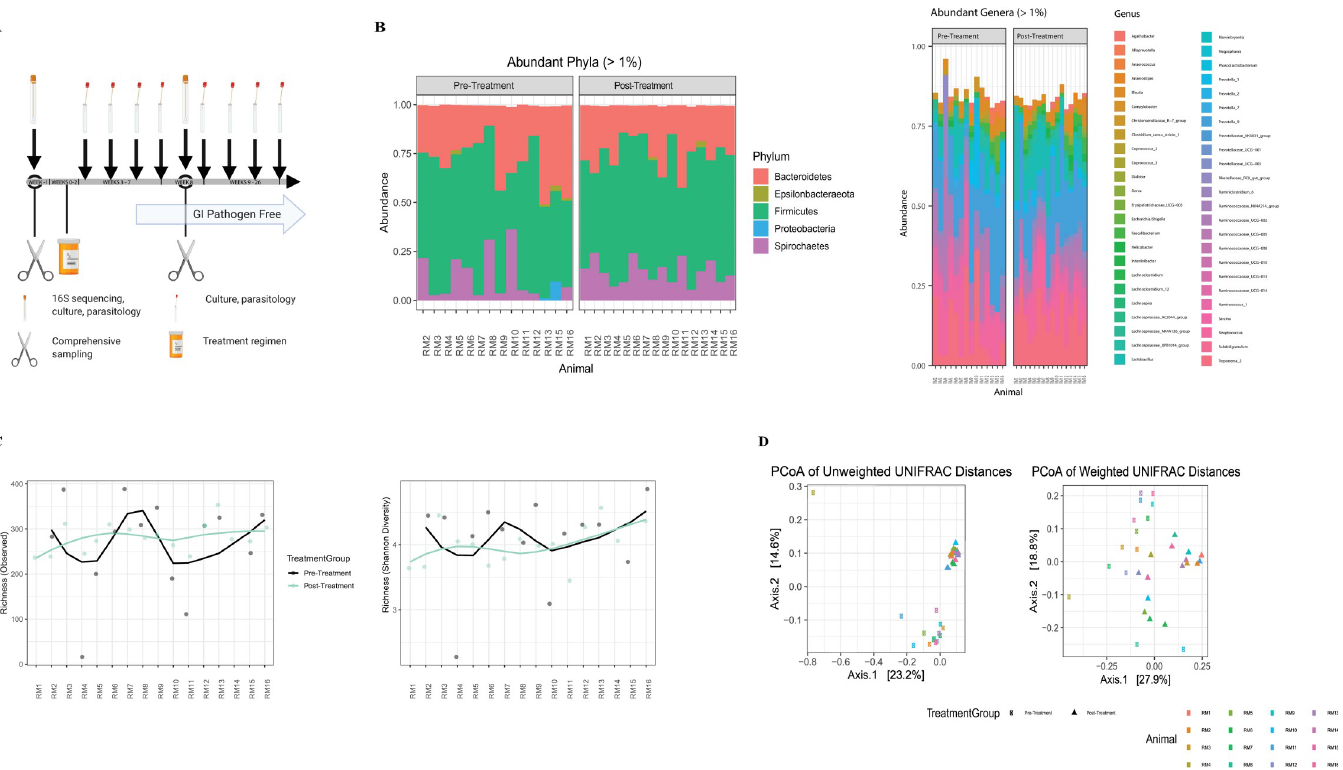
Fig 1. The multimodal therapy regimen does not cause microbiota diversity loss instead treatment decreases microbiota variation between individual study subjects. (A) Study design showing experimental timepoints for multimodal treatment administration, tissue and fecal sampling. Microbiota, fecal, parasitic assays and comprehensive surgical sampling performed (-1 week and 8 weeks), multi-modal therapy regimen (0–2 weeks), serial fecal and parasitic assays collected for remainder of study (2–26 weeks) (GPF after 3 consecutive negative results). (B) Gastrointestinal microbiota taxa distribution of the relative abundance of major ( > 1%) phyla (left) and ( > 1%) genera (right) comparing pre- and post-multimodal therapeutic regimen timepoints for study animals. Individual animals are represented by bar graphs and bacterial communities by a specific color designation (see figure key). (C) Comparison of alpha diversity by the measurement of observed richness (left) (p = .457) and Shannon diversity (right) (p = 0.875) of pre and post treatment timepoints for all study animals, statistical significance determined by paired two-way t-test. (D) Beta diversity measured by Principal Coordinate Analysis plots of the unweighted and weighted UniFrac of the pre- and post-treatment timepoints for all study animals, assessed by PERMANOVA (p = .001)(individual animals designated by color, study time points by shape (pre-treatment = o, post-treatment = Δ